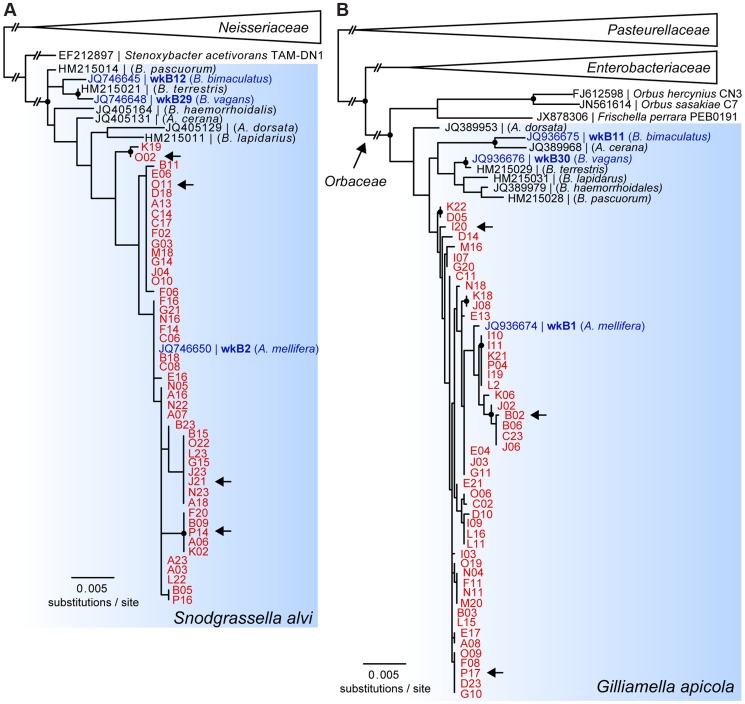
16S rRNA-based maximum likelihood trees of SAGs of (A) S. alvi and (B) G. apicola.SAGs are highlighted in red and denoted according to their position in the 384-well plate. Reference strains isolated from honey bees and bumble bees with available genome sequences are highlighted in blue. Arrows indicate SAGs selected for genome sequencing. Trees were inferred from (A) 1,229 and (B) 1,167 aligned nucleotide sites of partial 16S rRNA sequences of S. alvi and G. apicola, respectively. Nodes with bootstrap values ≥80 (100 replicates) are marked with black circles. In (A), S. alvi and Stenoxybacter acetivorans are part of the larger Neisseriaceae family, while in (B) G. apicola belongs to the family of Orbaceae together with the species Orbus hercynius, Orbus sasakiae, and F. perrara. Branches to distantly related outgroup species are collapsed, and long branches are shortened, as indicated by two interrupting vertical dashes.